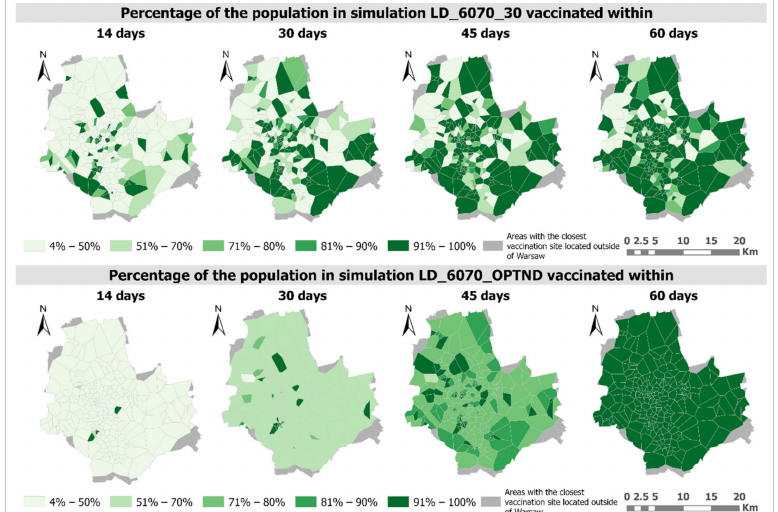
Figure 13. Percentage of the population of studied age groups that will be vaccinated within a specified number of days in LD_6070_30 and LD_6070_OPTND